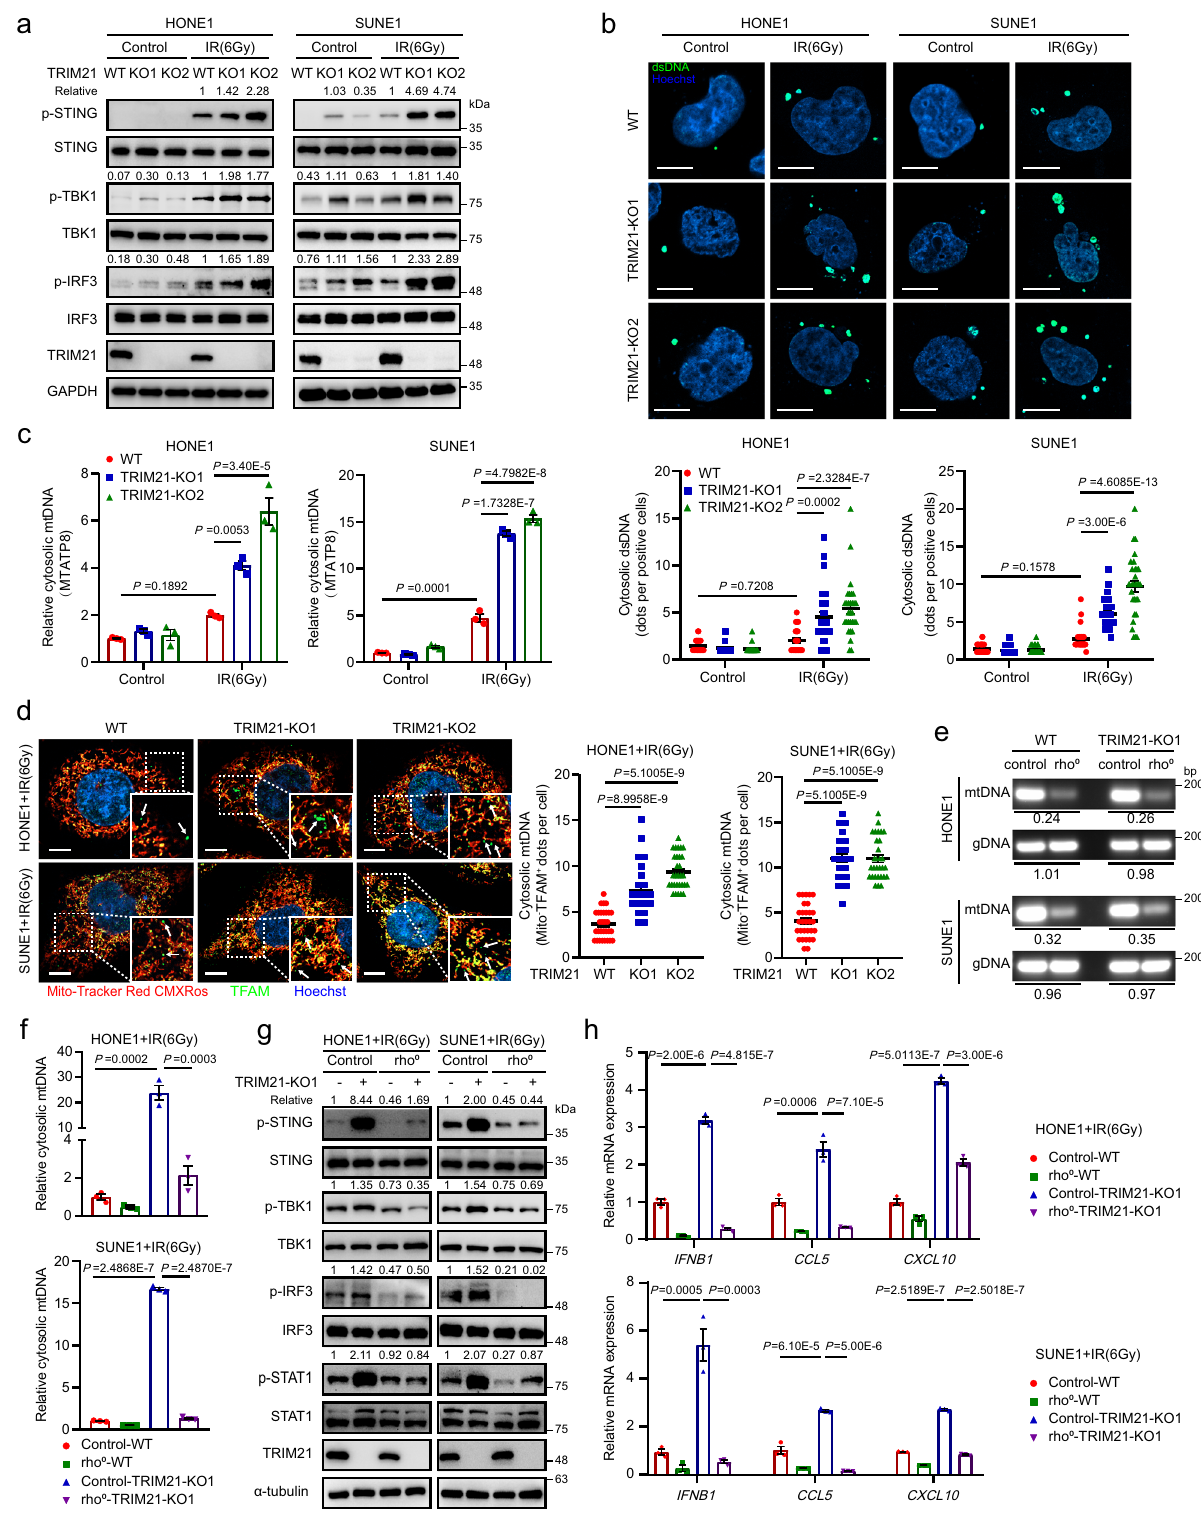
Fig. 4d and Supplementary Table 2). Then, a Lys/Arg substitution mutant (K135R) of VDAC2 was generated. By restoring the expres- sion of TRIM21 and VDAC2 (WT or the K135R mutant) in TRIM21/ VDAC2 double-knockout NPC cells, we found that the half-life of VDAC2-K135R was signi fi cantly prolonged compared to that of VDAC2-WT (Fig. 3l). Consistent with this fi nding, VDAC2-K135R was resistant to TRIM21-mediated ubiquitination (Fig. 3m). Taken